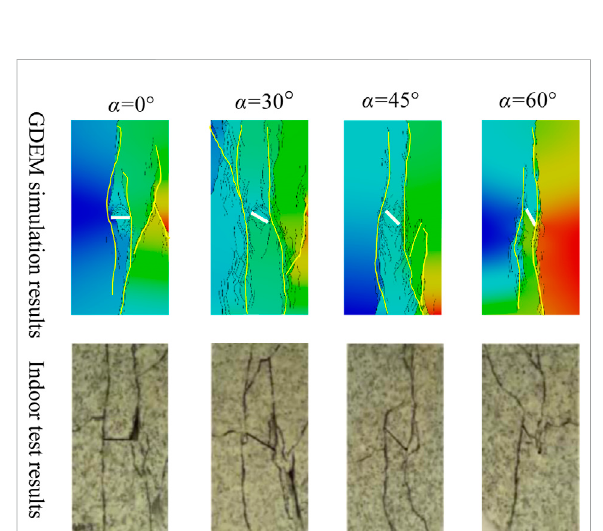
FIGURE 1 Continuous – discontinuous calculation principle.